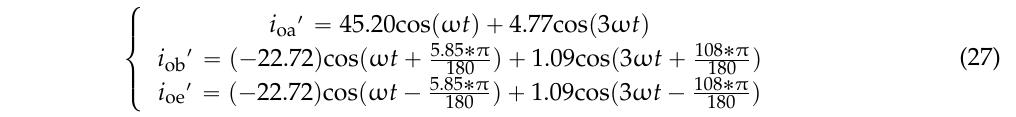
Figure 23. The motor operates under non ‐ adjacent double ‐ phase open circuit in outer motor conditions: ( a ) electromagnetic torque obtained by FEA; ( b ) the injected currents of the outer motor. Torque details (average torque, torque ripple etc. ) of these fault types in Section 3.2 are shown in Table 11. The torque ripple is much smaller when fault ‐ tolerant techniques are adopted. Faults in the outer motor are much worse compared to the inner motor because the outer motor contributes more torque to the total torque. The same as in series drive mode, the adjacent double phase fault is the most severe fault type. 3.3. Double ‐ Phase Open ‐ Circuit in One Side of Motor with Single ‐ Phase Open ‐ Circuit in the Other Side of Motor Fault ‐ Tolerance Technique There are also four fault types in this fault situation: (I) Non ‐ adjacent double ‐ phase open ‐ circuit in the outer motor with single ‐ phase open ‐ circuit in the inner motor (Figure 24a); (II) Adjacent double ‐ phase open ‐ circuit in the outer motor with single ‐ phase open ‐ circuit in the inner motor (Figure 24b); (III) Adjacent double ‐ phase open ‐ circuit in the inner motor with single ‐ phase